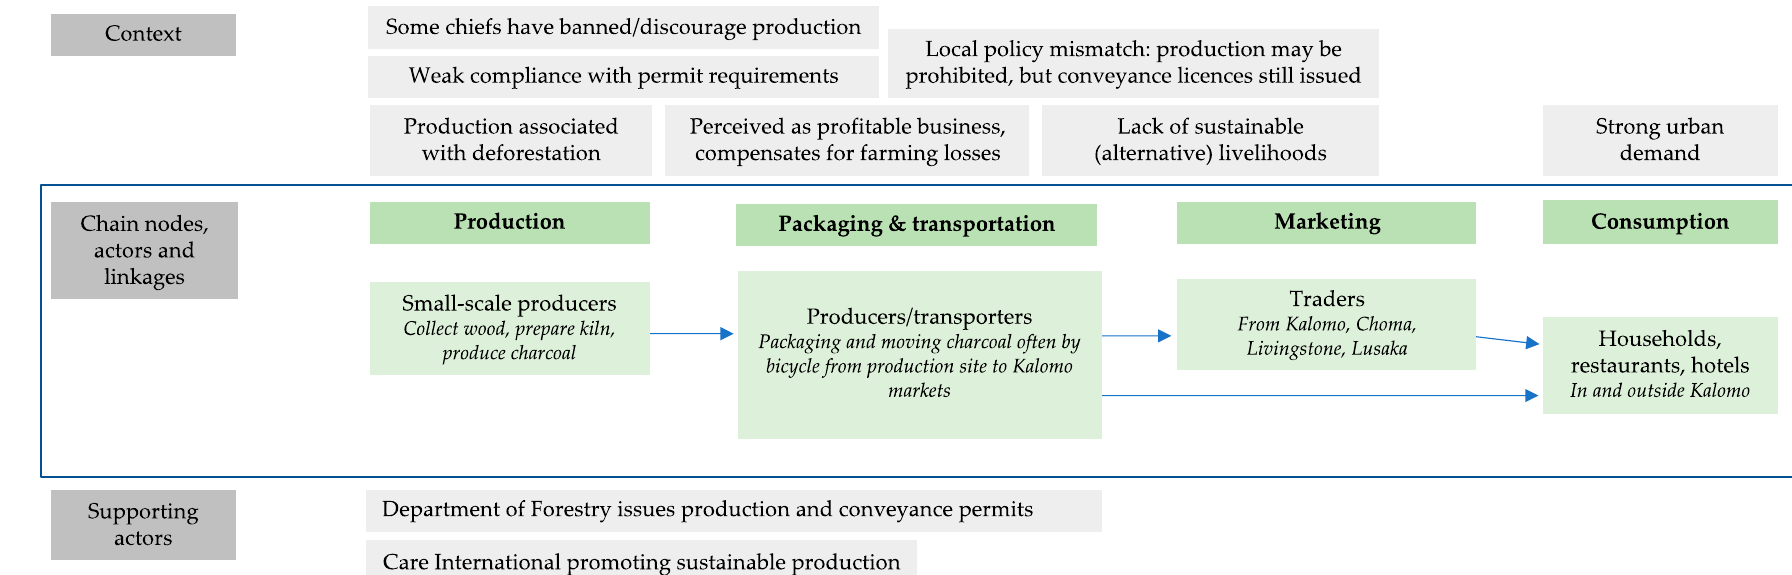
Figure 6. Charcoal value chain and context in Kalomo District (Source: Authors’ construct based on field research data).